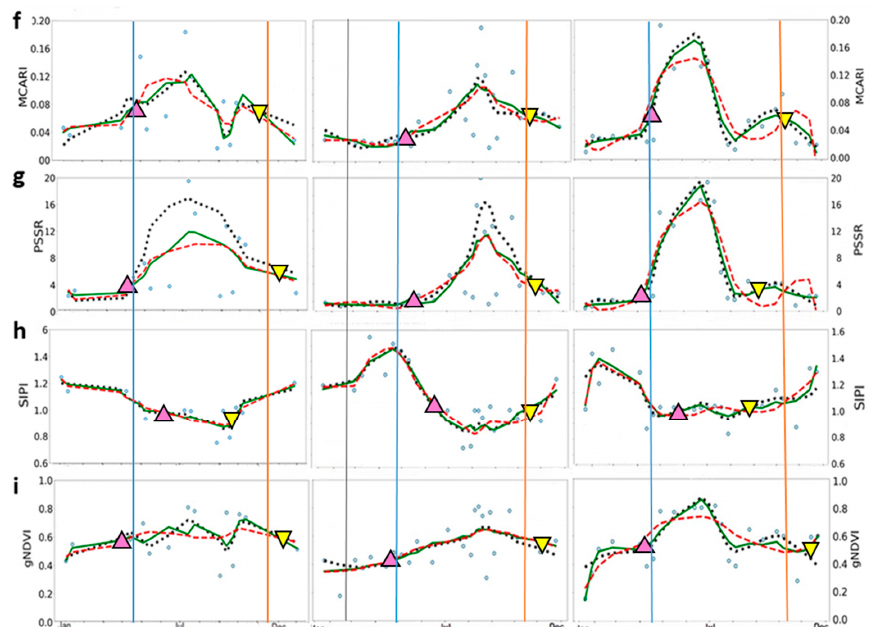
Figure 3. Time-series of the seasonal variation of midday Gross Primary Productivity (GPP) and vegetation indices derived from Sentinel-2 images. ( a ) GPP (in mol m − 2 s − 1 ); ( b ) NDVI—Normalized Difference Vegetation Index; ( c ) EVI—Enhanced Vegetation Index; ( d ) MTCI—MERIS Terrestrial Chlorophyll Index; and ( e ) ChlRedEdge—Chlorophyll red-edge; ( f ) MCARI—Modified Chlorophyll Absorption Ratio Index; ( g ) PSSR—Pigment Specific Simple Ratio; ( h ) SIPI—Structure Insensitive Pigment Index; ( i ) gNDVI—Green Normalized Difference Vegetation Index. Blue circles represent original data; dotted black lines represent HANTS series fitted data; green lines Savitzky–Golay (SavGol) series fitted data; and dashed red lines polynomial (Polyfit) series fitted data. Up-pointing pink and down-pointing yellow triangles represent mean values, in days, of the start and the end of season, respectively, derived from filtering methods. Blue and orange lines indicate the start and the end of season of GPP, respectively.